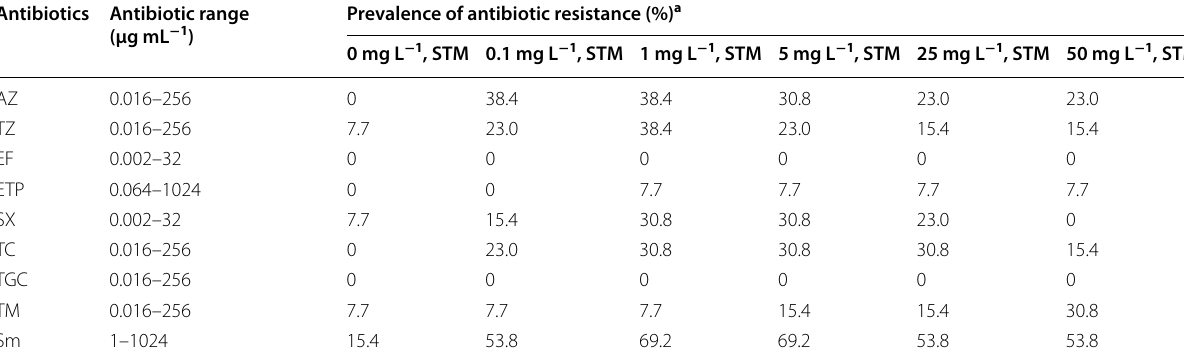
AZ azithromycin, TZ ceftazidime, EF enrofloxacin, ETP ertapenem, SX sulfamethoxazole, TC tetracycline, TGC tigecycline, TM tobramycin, STM streptomycin a A total of 40 different bacterial strains (78 bacterial isolates, i.e. 13 isolates from each Sm stage) were used for MIC assay and the percentage of antibacterial resistance was calculated by the number of resistant strains among the total stains